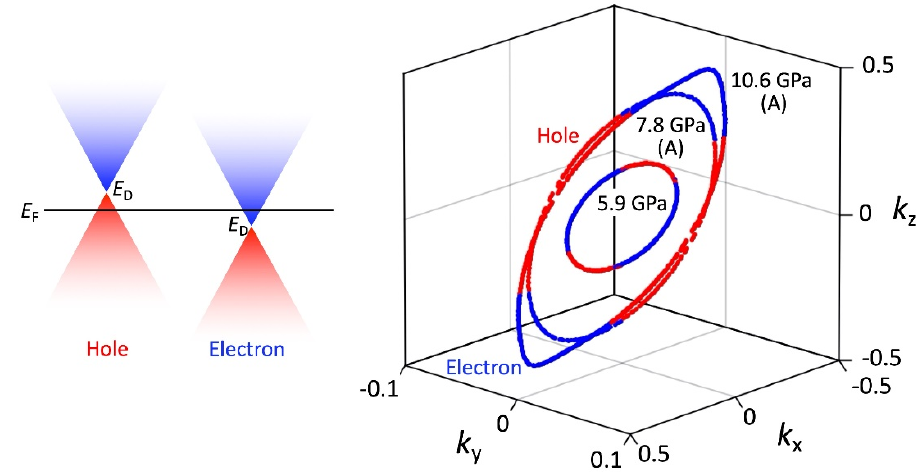
Figure 7. Nodal loops in [Pd(dddt) 2 ] at 5.9 GPa, 7.8 GPa and 10.6 GPa. Points with hole-like characteristics are indicated in red and points with electron-like characteristics in blue.